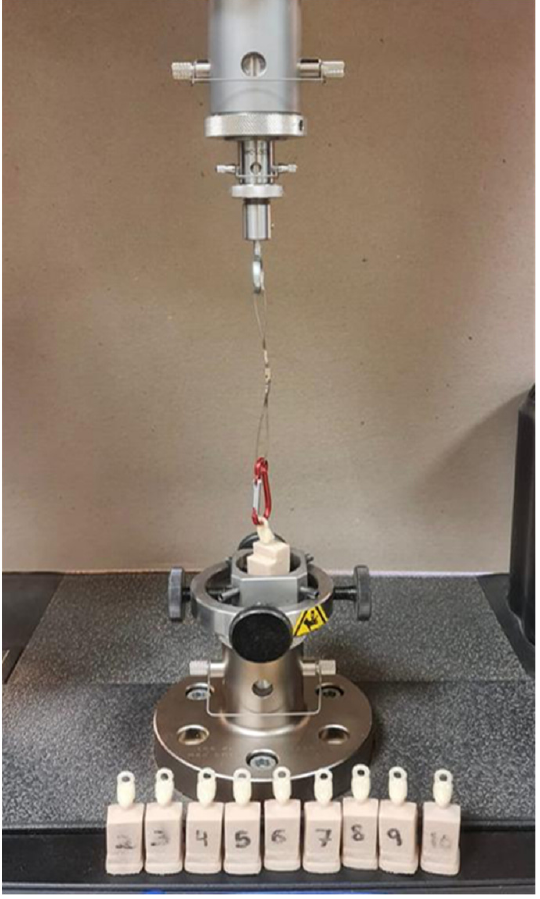
Figure 6. Specimen subjected to the retention test in the universal testing machine. The retention in newtons (N) was measured by separating the crowns from the pre- pared teeth under tension on the universal testing machine. The retention of crowns using a similar crown pull-off test with a universal testing machine was conducted in previous studies